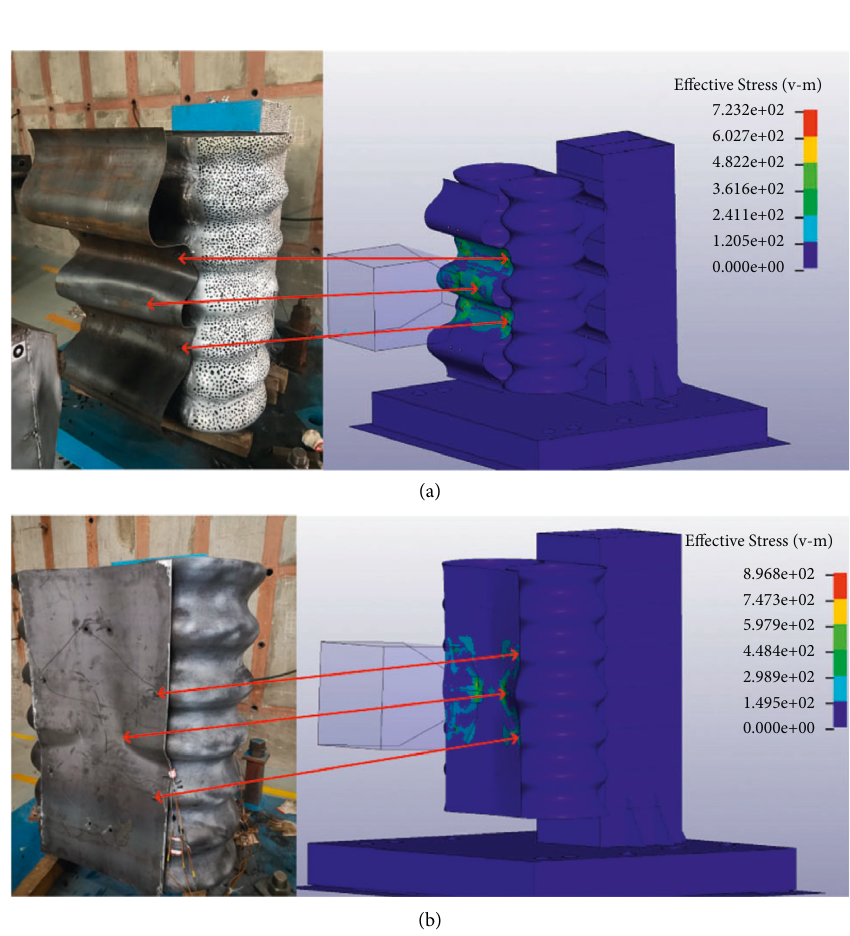
Figure 4: Deformation of steel plate at the impact. (a) CSP-2.75-4; (b)